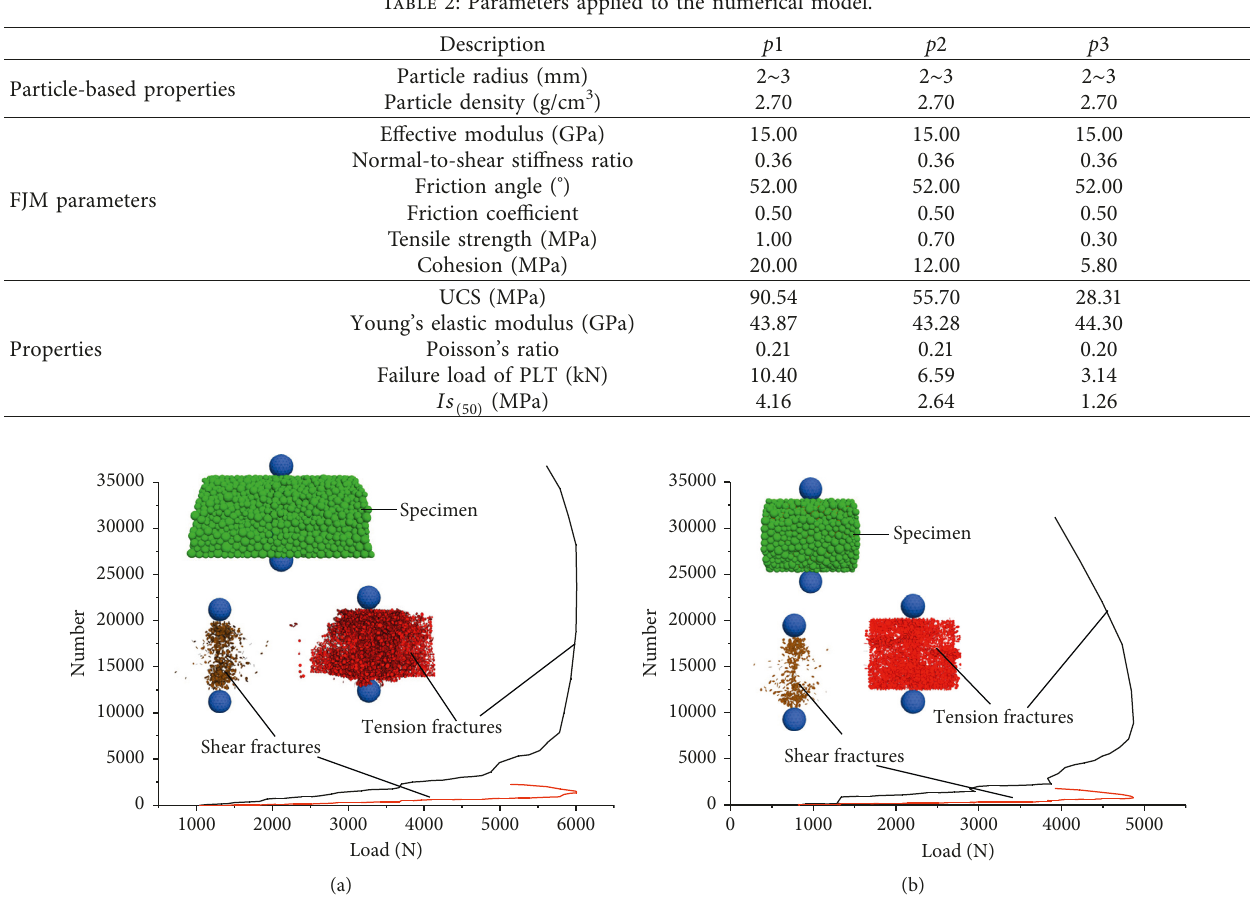
Table 2: Parameters applied to the numerical model.